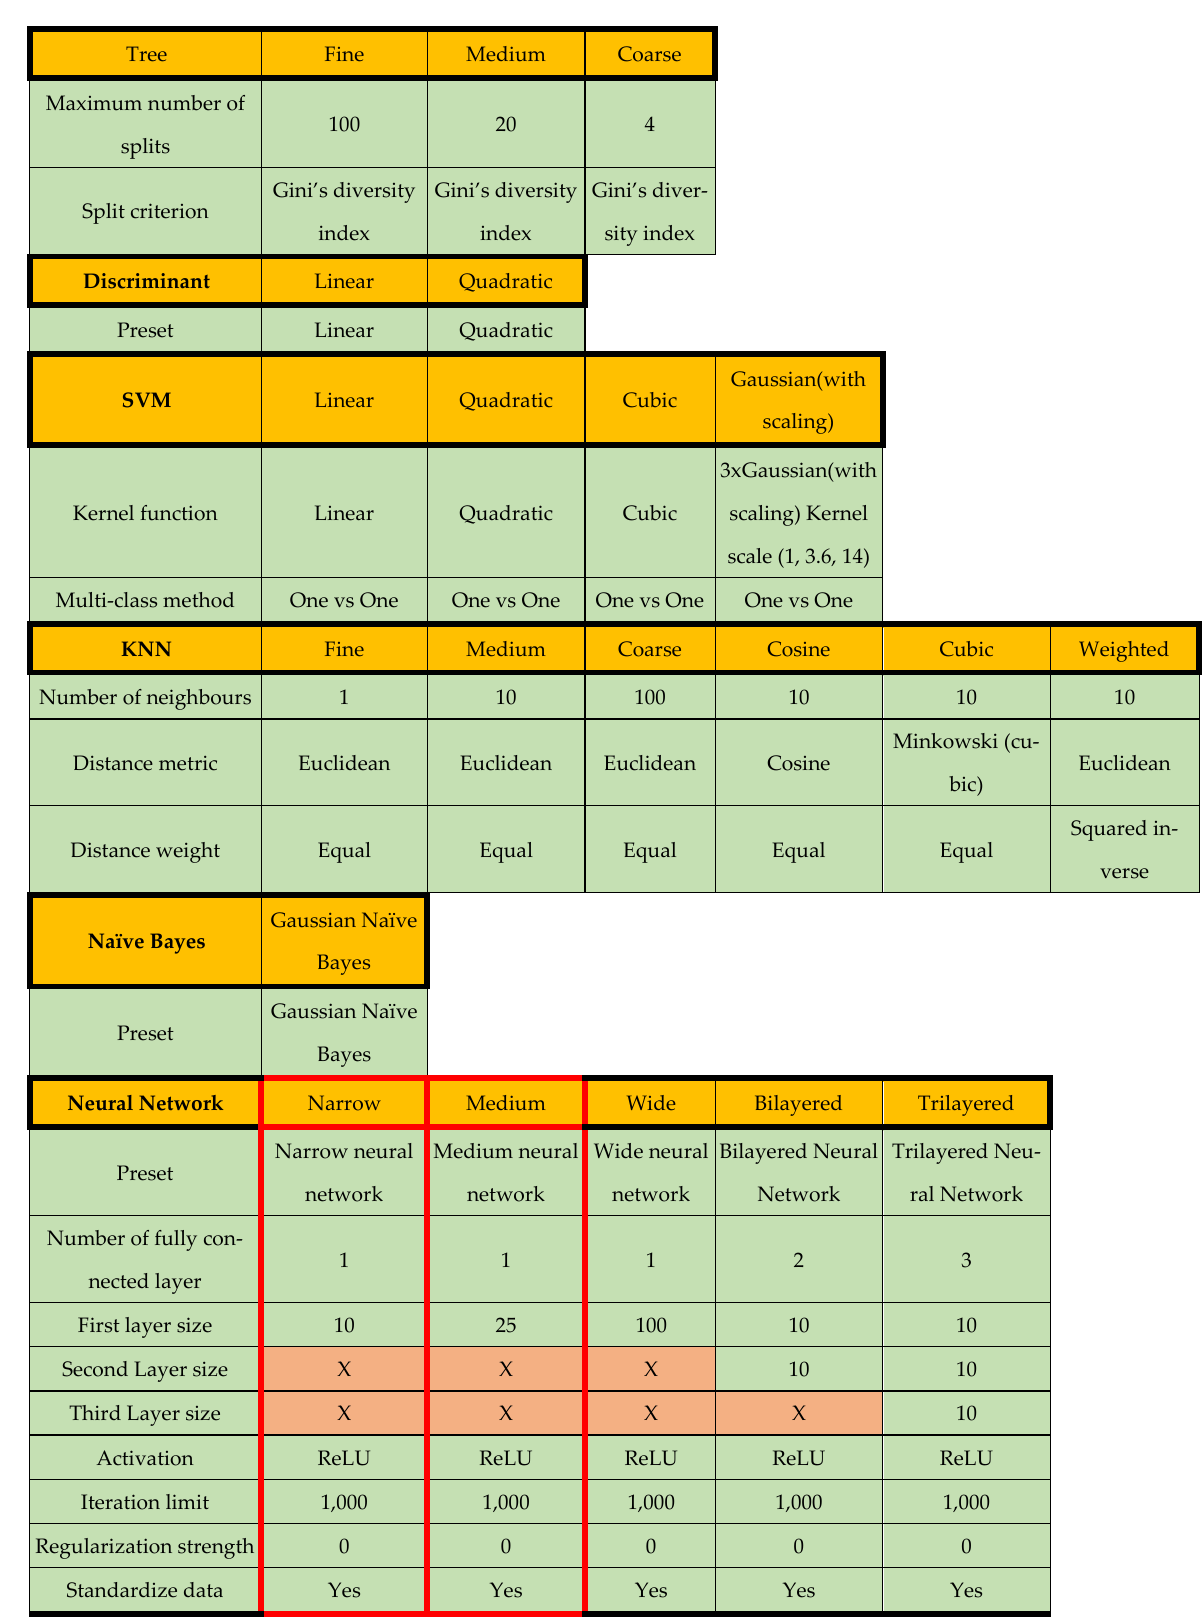
Table 1. Classifiers with selected hyperparameters.